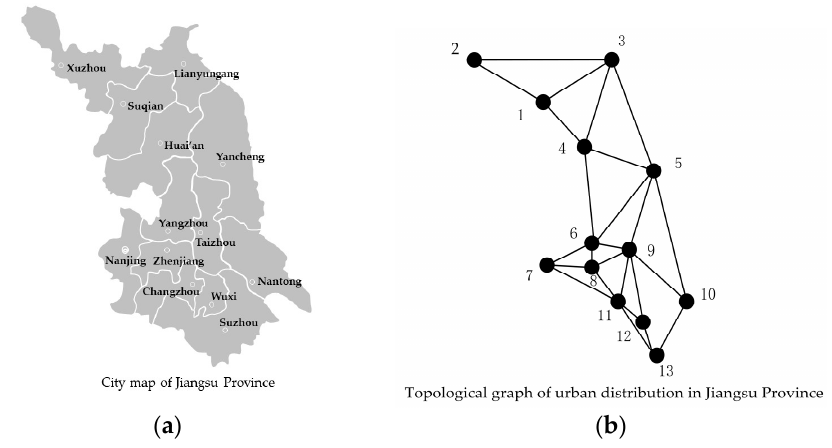
Figure 2. The adjacent relationship between cities in Jiangsu Province.